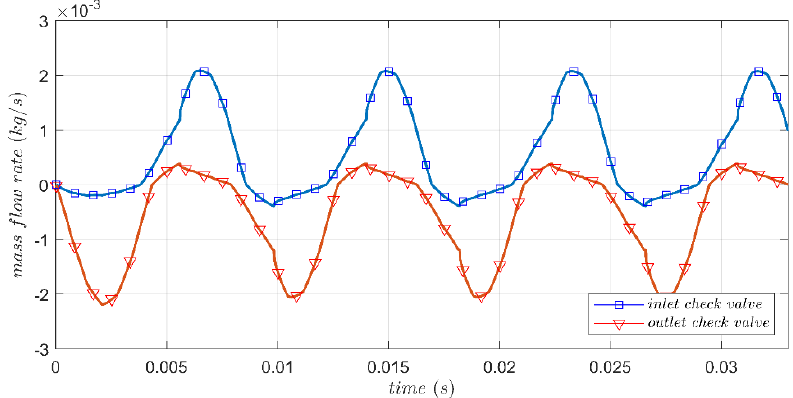
Figure 8. The transient flow rate result at 120 Hz.